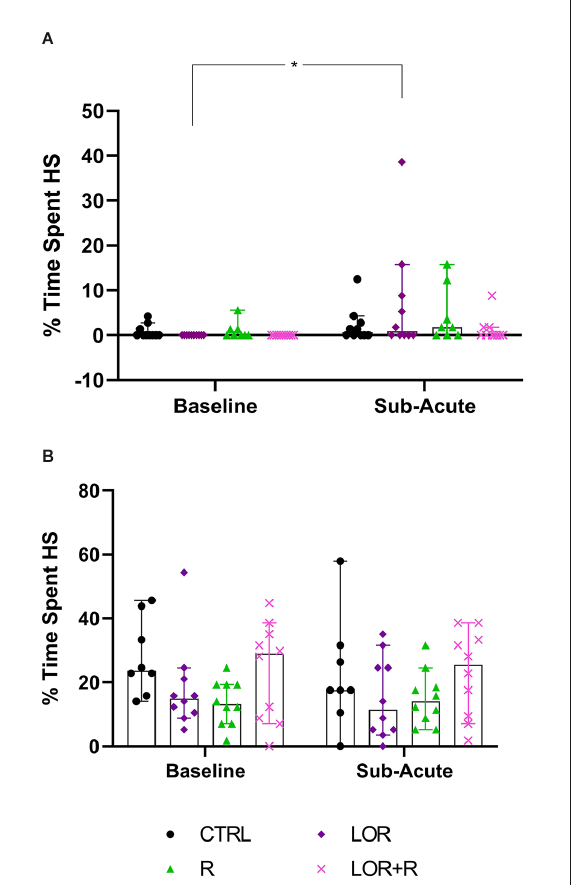
FIGURE4 Average whole-night stereotypical intensity shown at the sub-acute phase in (A) NS and (B) HS mice exposed to CTRL, R, L, and LOR+R. 2-way RM ANOVA followed by Bonferroni’s multiple comparisons tests. Data represent the median ± 95CI. ** p < 0.01; CTRL, control (drug- and restriction-naïve animals); R, behavioral restriction; L, lorazepam; LOR+R, lorazepam combined with behavioral restriction.